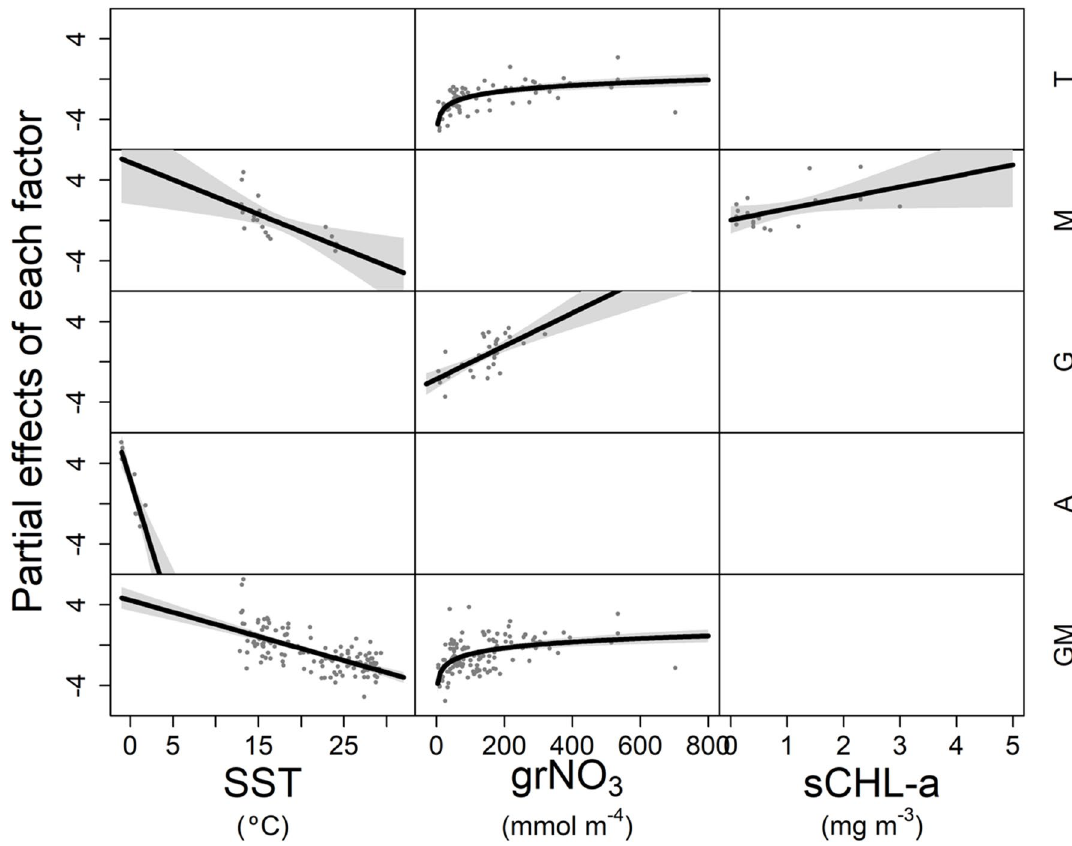
Figure 3. Partial effects and residuals of nitrate diffusive flux as a function of predictors. The response variable was computed as a smooth function of sea surface temperature (SST), vertical nitrate gradient (grNO 3 ) and surface chlorophyll-a (sCHL-a) for tropical and subtropical regions (T), the Northwest Mediterranean (M), the Galician coastal upwelling (G), the Antarctic Peninsula (A), and for the complete dataset except those stations collected in the Antarctic Peninsula (GM). All terms were centered in zero. Relationships where p-value < 0.05 are indicated as solid black lines, whereas no significant relationships are indicated as empty pannels. Intercepts and parameters are indicated in Table